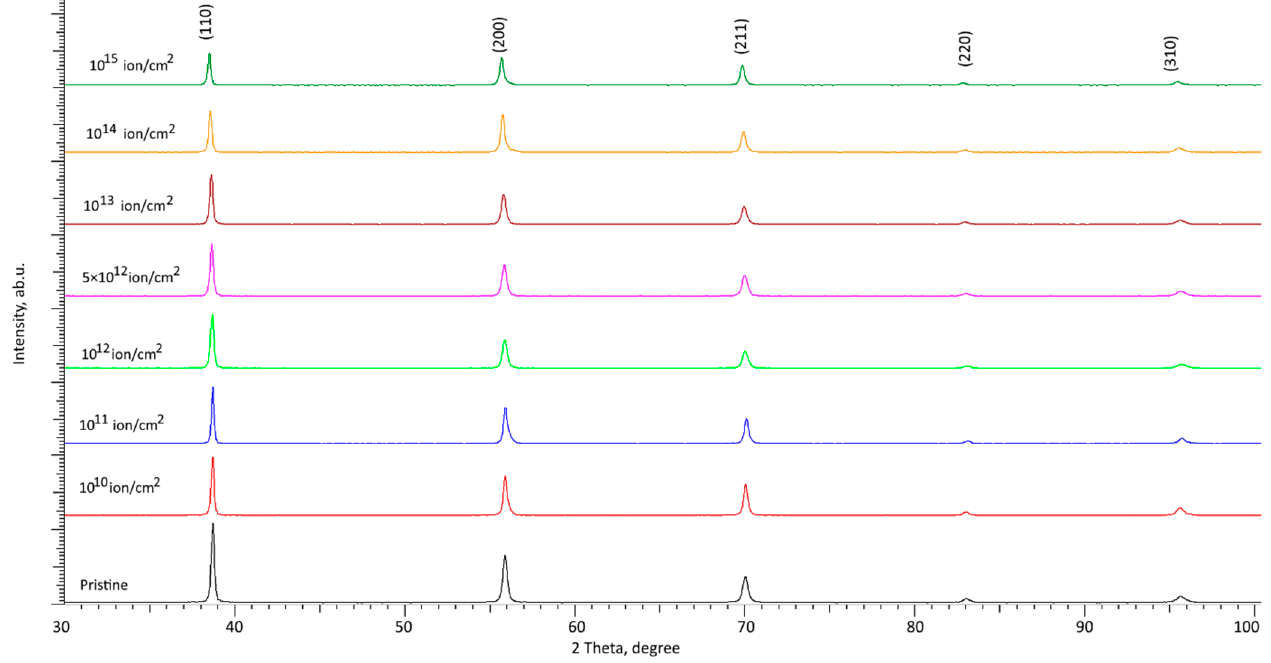
Figure 4. X-ray diffraction patterns of NbTiVZr alloys plotted against fluence of irradiation with Figure 4. X-ray di ff raction pa tt erns of NbTiVZr alloys plo tt ed against fl uence of irradiation with heavy Kr 15+ ions. heavy Kr 15+